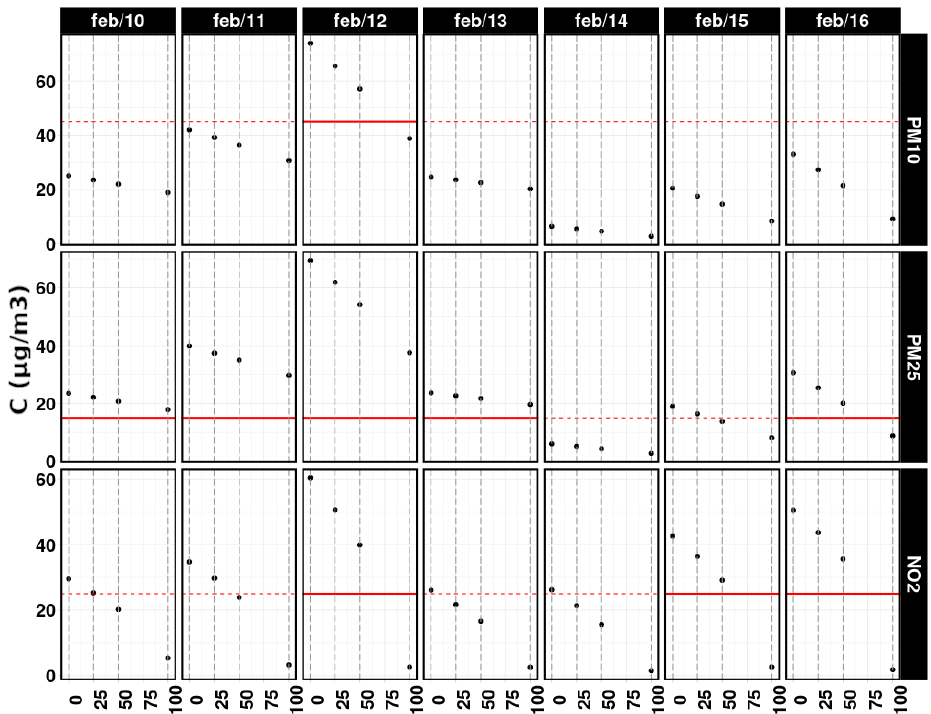
Figure 7. Effect of multiple reduction scenarios (0%, 25%, 50% and 100%) on mean averaged surface concentrations of PM 10 , PM 2.5 and NO 2 . Spatial average is performed over urban cells and time average is the daily average (for 10 to 16 february). The WHO threshold is displayed with a red dashed line, except when concentrations are over this limit (red solid line). The simulations used here are for scenarios where reductions are applied to all